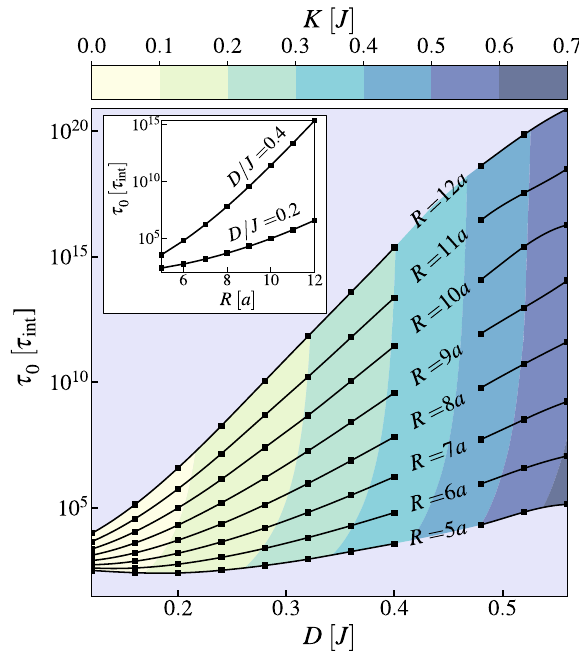
Fig. 3 Results of pre-exponential factor calculations within HTST. Variation of the Arrhenius pre-exponential factor τ 0 along several contours of equal skyrmion radius R . Color codes distribution of the reduced anisotropy parameter. The inset shows R dependence of τ 0 for the two values of the reduced DM interaction parameter. Filled squares indicate the calculated data points.